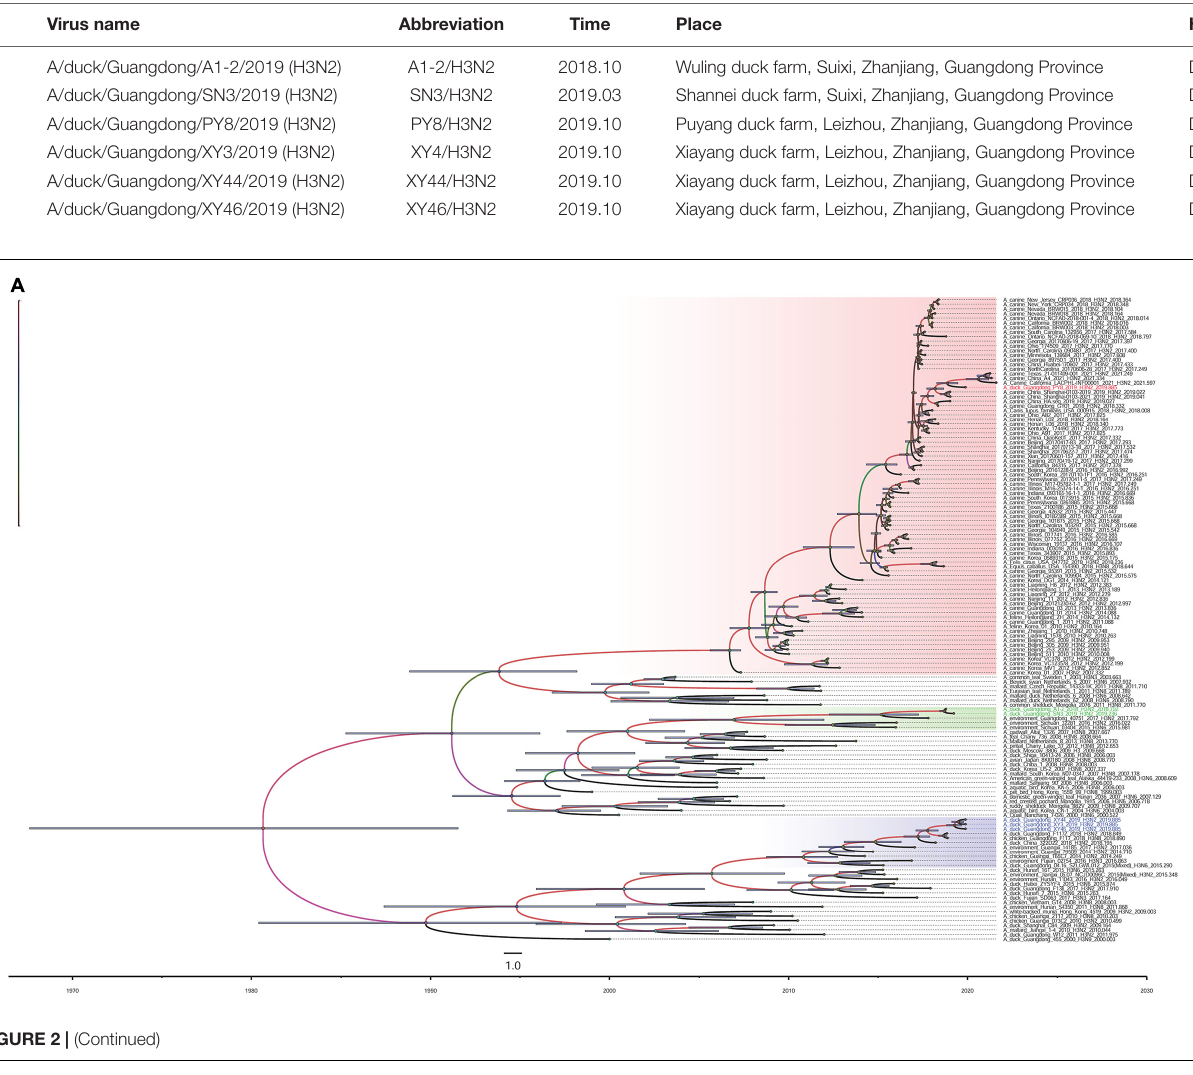
TABLE 1 | Information of the 6 avian influenza